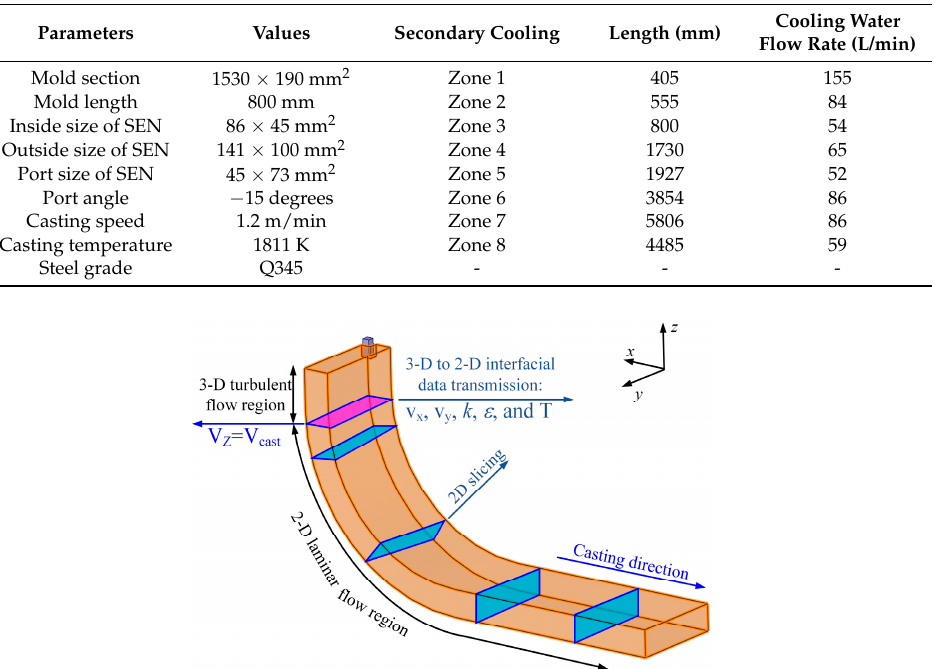
Table 1. The geometry and working parameters of the CC (continuous casting) process.